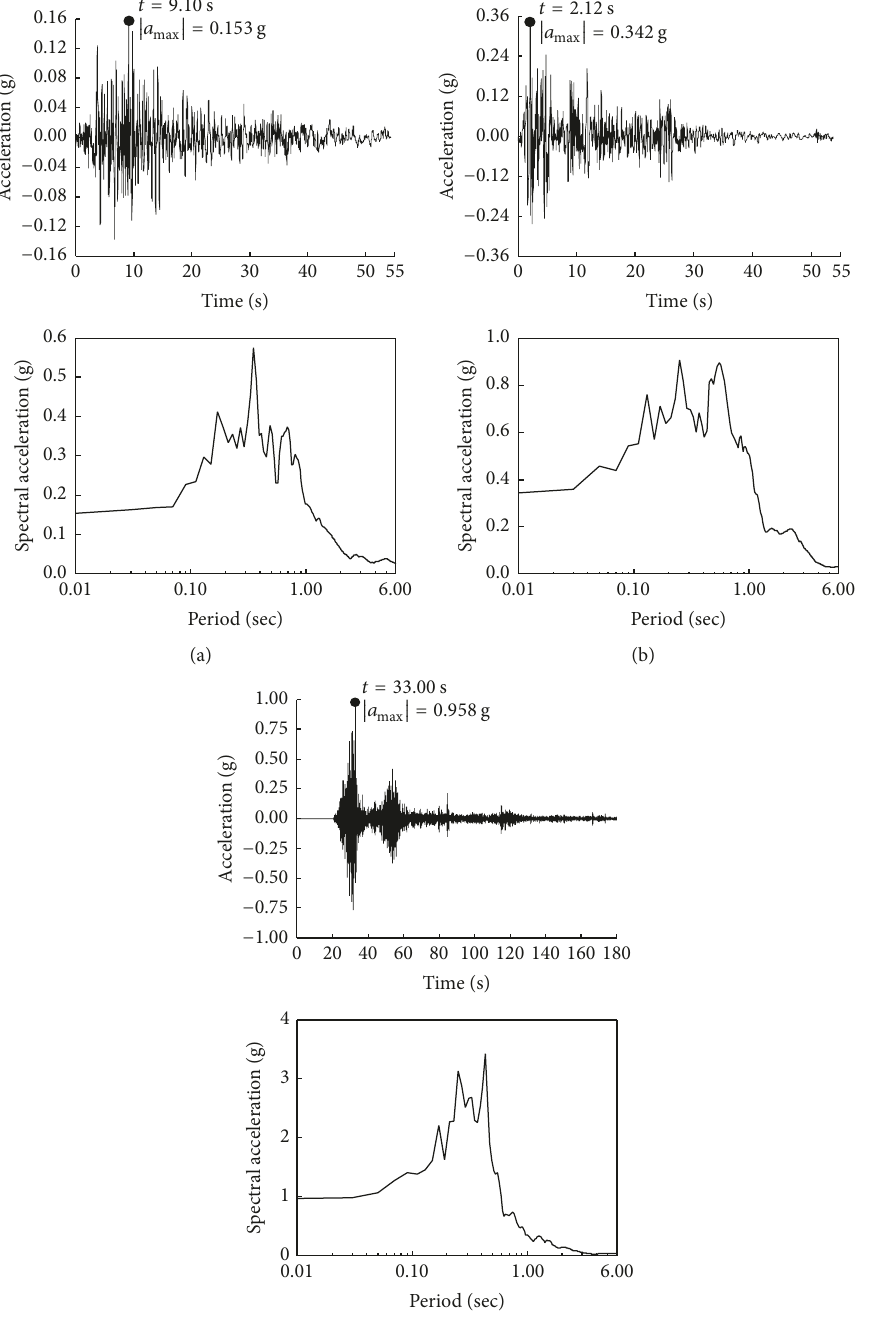
Figure 9: Acceleration time histories and spectral acceleration of the ground motion records: (a) Taft record, (b) El Centro record, and (c) Wolong record